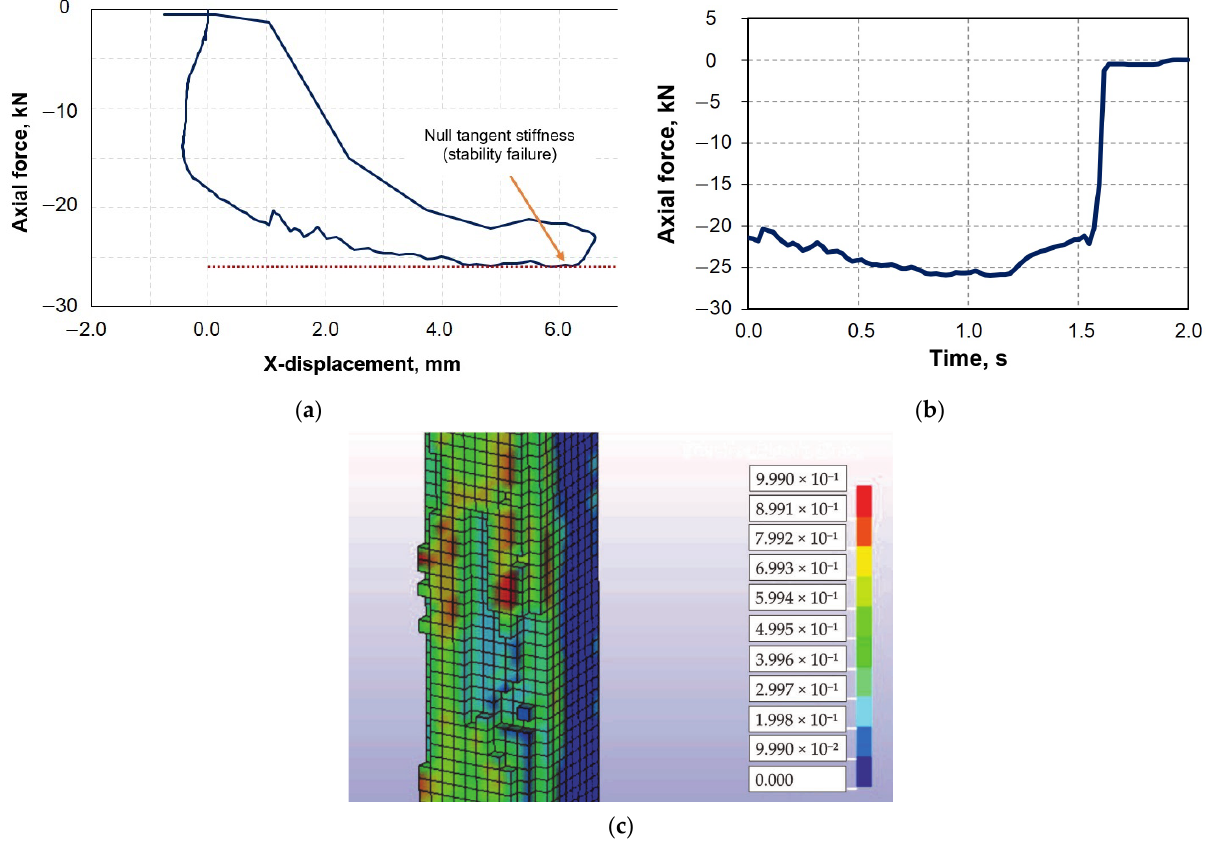
Figure 19. The axial force–X displacement curve ( a ), history of axial force ( b ), and effective plastic strain when tangent stiffness is null ( c ) for a section in the middle part of column 2.